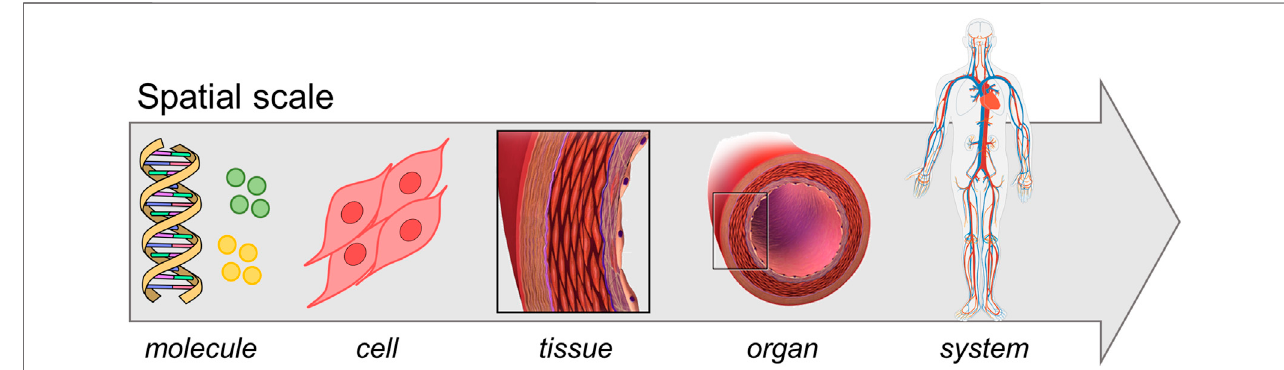
FIGURE 1 | Multiscale vascular system. Adapted with permission from Wikimedia Commons, (public domain, https://commons.wikimedia.org/wiki/File:DNA_ simple2.svg, https://commons.wikimedia.org/wiki/File:Circulatory_System_no_tags.svg), Blausen.com staff (2014) (https://creativecommons.org/licenses/by/3.0/), and from Blanco et al. (2017) (http://creativecommons.org/licenses/by-nc/4.0/).